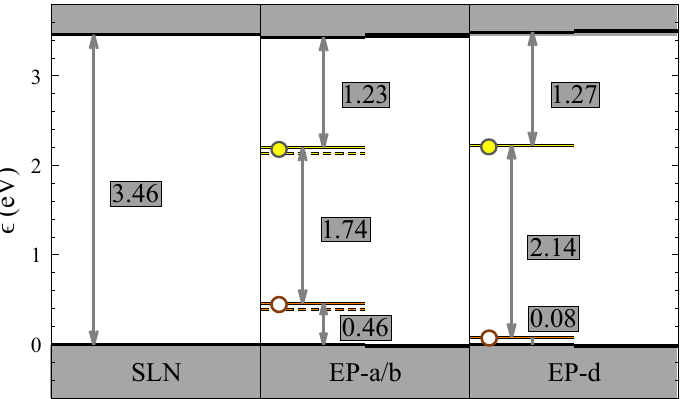
Figure 3. Positions of the one-particle defect levels obtained within DFT + U ( U only at the Nb atoms) relative to the valence- and conduction-band edges for stoichiometric LN and different exciton- polaron configurations with fully relaxed lattice structures. The left half of each panel shows the spin-down channel, where the exciton is formed; the spin-up channel in the right half remains unaffected. The yellow and orange lines mark the energy levels of the occupied electron state and the unoccupied hole state, respectively. The numerical values in the central panel refer to the EP-a; for the EP-b, both defect levels are 0.07eV lower as indicated by the dashed lines, leaving their mutual distance